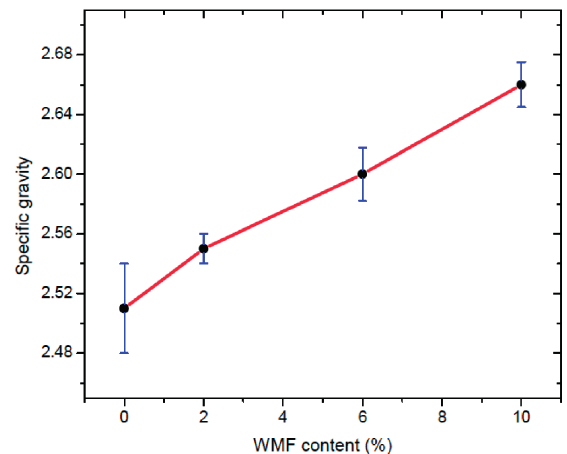
Fig. 4. Variation of specific gravity of the treated soil samples with their WMF contents